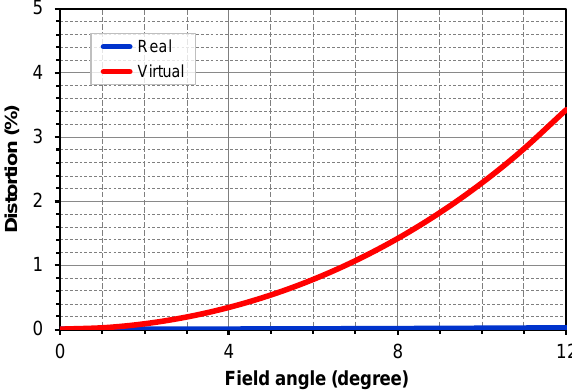
Figure 11. Calculated distortion with respect to the field angle. It can be seen that the distortions are 0.02% and 3.4% for the real and virtual images,